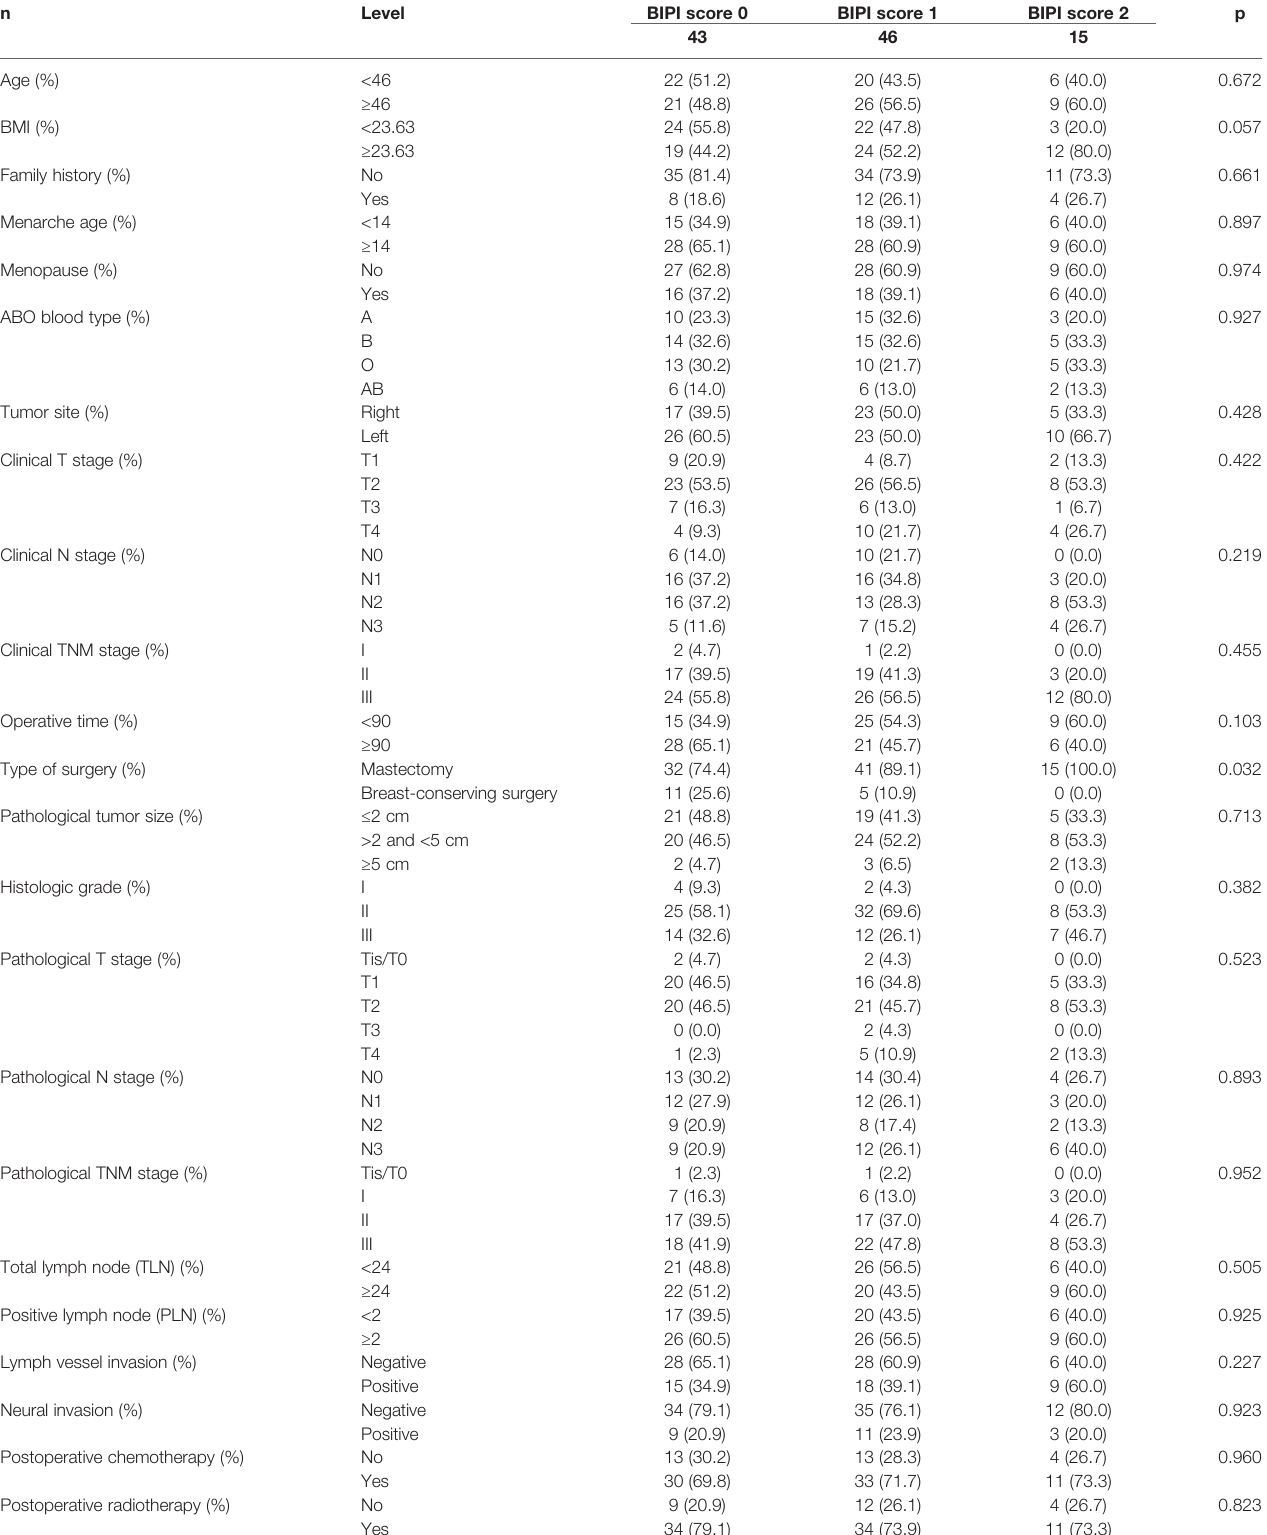
TABLE 1 | Patients ’ characteristics for all patients in accordance with breast immune prognostic index